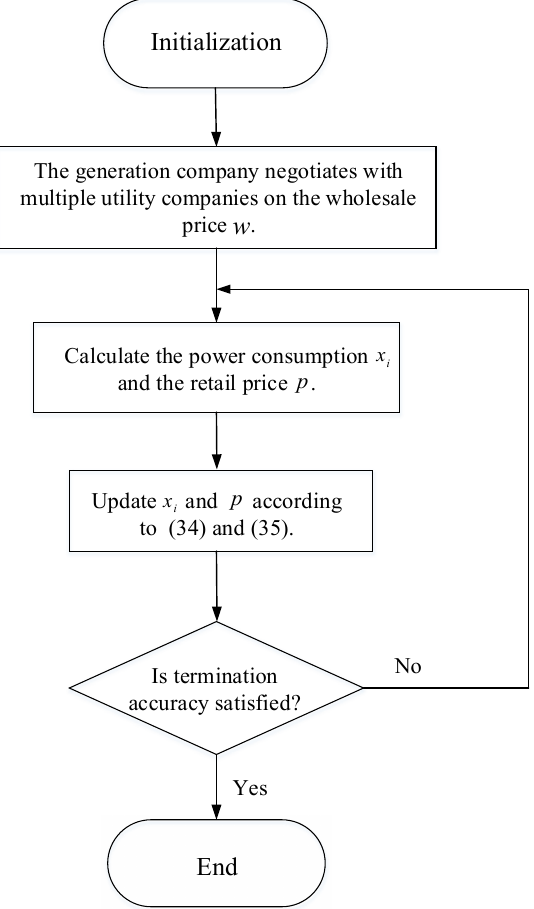
Figure 4. The flowchart of the pricing regulation